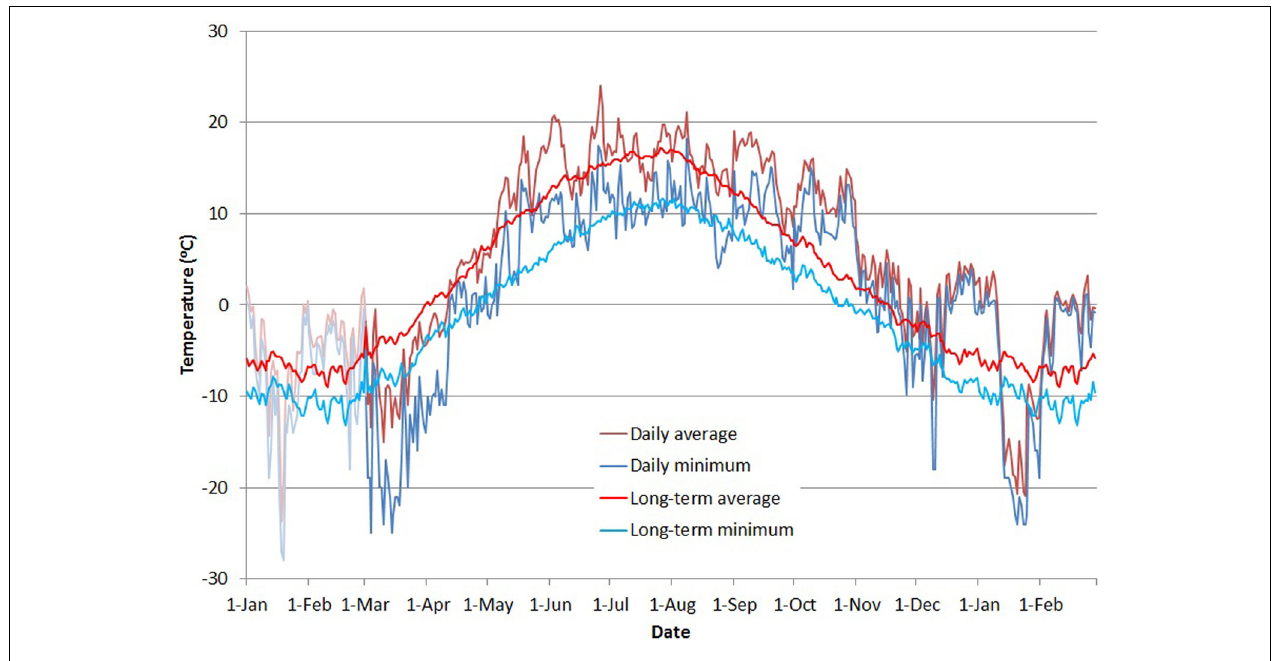
FIGURE 2 | Average (red line) and minimum (blue line) daily temperatures during the study period. Stronger colors indicate the period of fluorescence measurements, with 2 months preceding the period presented in shaded colors. The thinner red